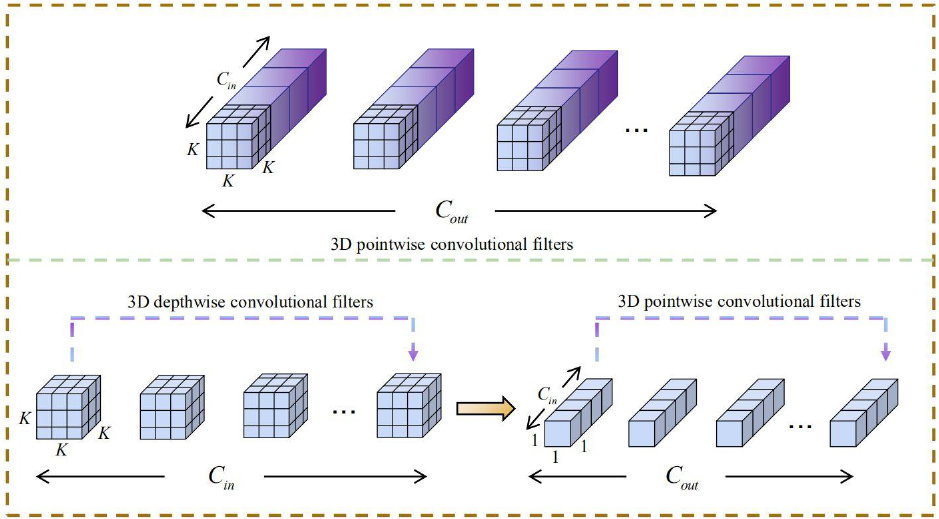
Figure 3. A comparison of a 3D standard convolution kernel and a 3D depthwise separable convolution kernel.